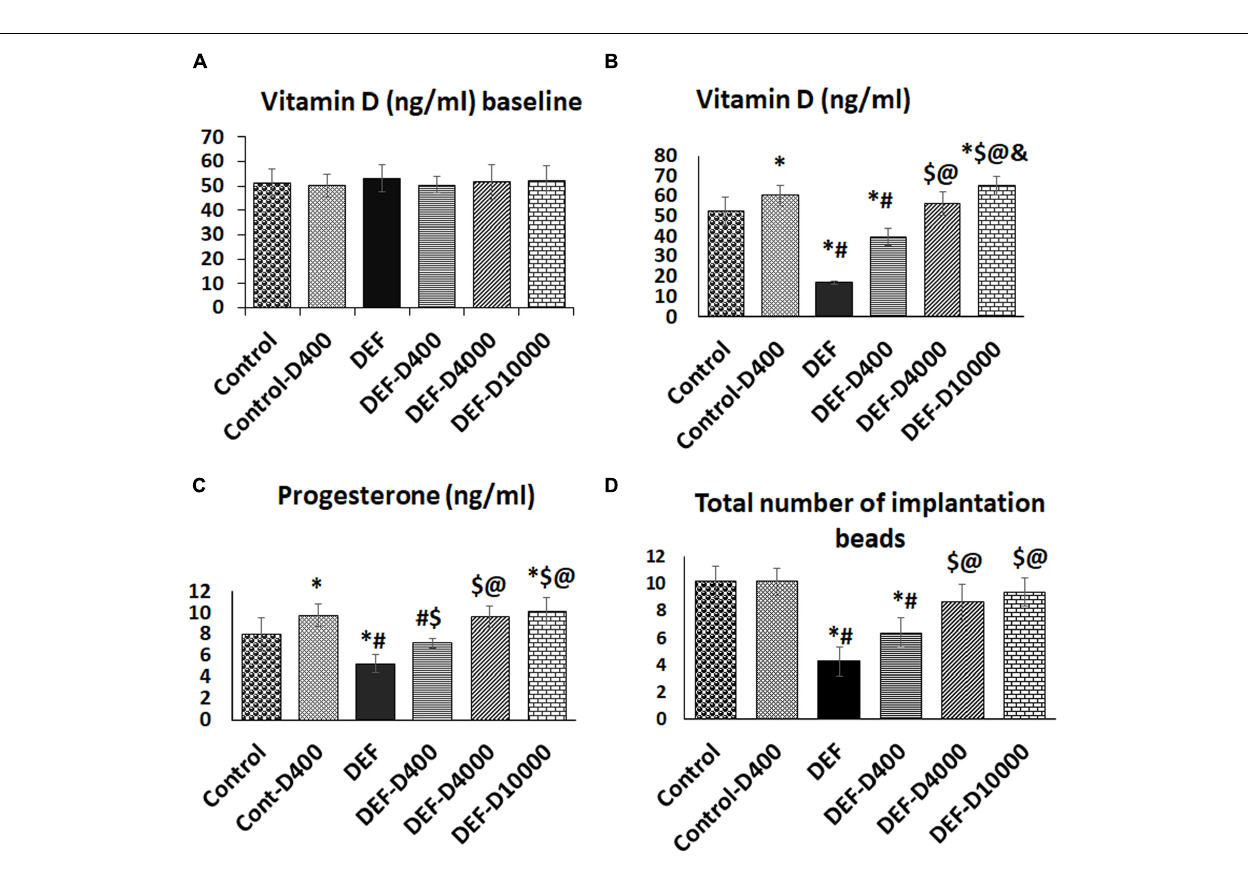
Frontiers in Physiology |